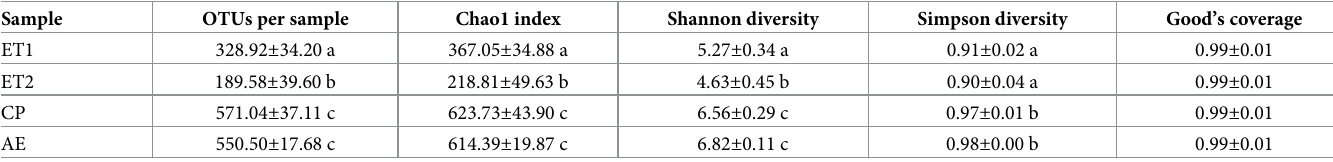
Table 4. Alpha diversity indexes for chicken cecal Argentine samples.